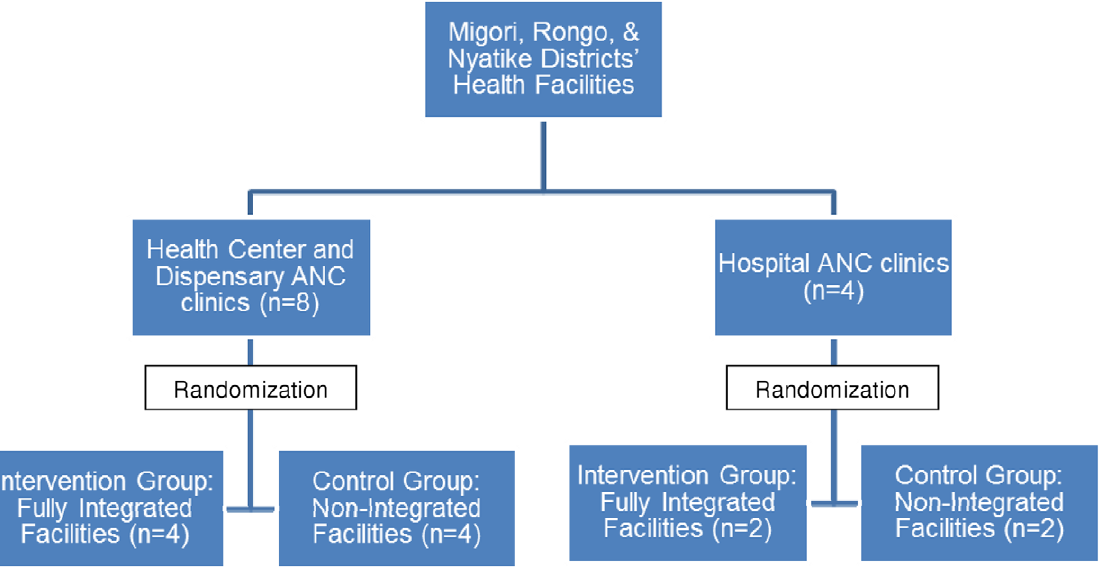
Figure 3. Randomization of clinic sites. Twelve facilities were categorized by facility type, as either ‘‘Health Center or Dispensary’’ (N=8) or ‘‘Hospital’’ (N=4). Within these strata, each clinic represented a cluster, and was randomized to either control (Non-Integrated) or intervention (Fully Integrated) using the ACluster software.